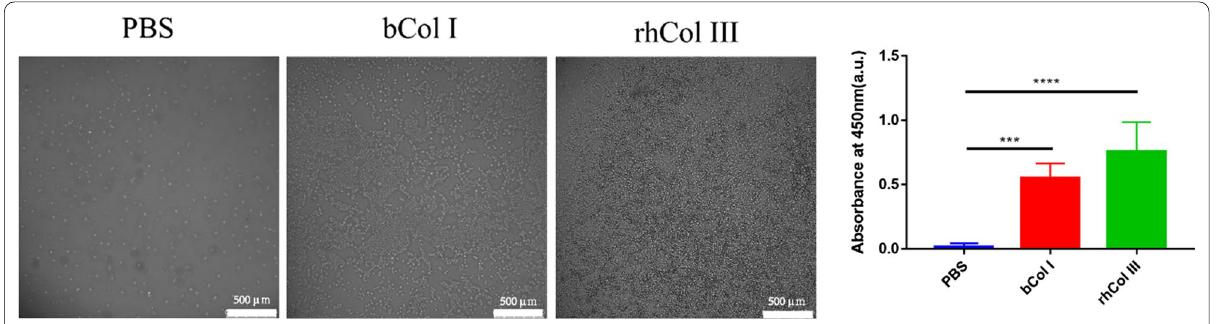
Fig. 4 HSF adhesion in different